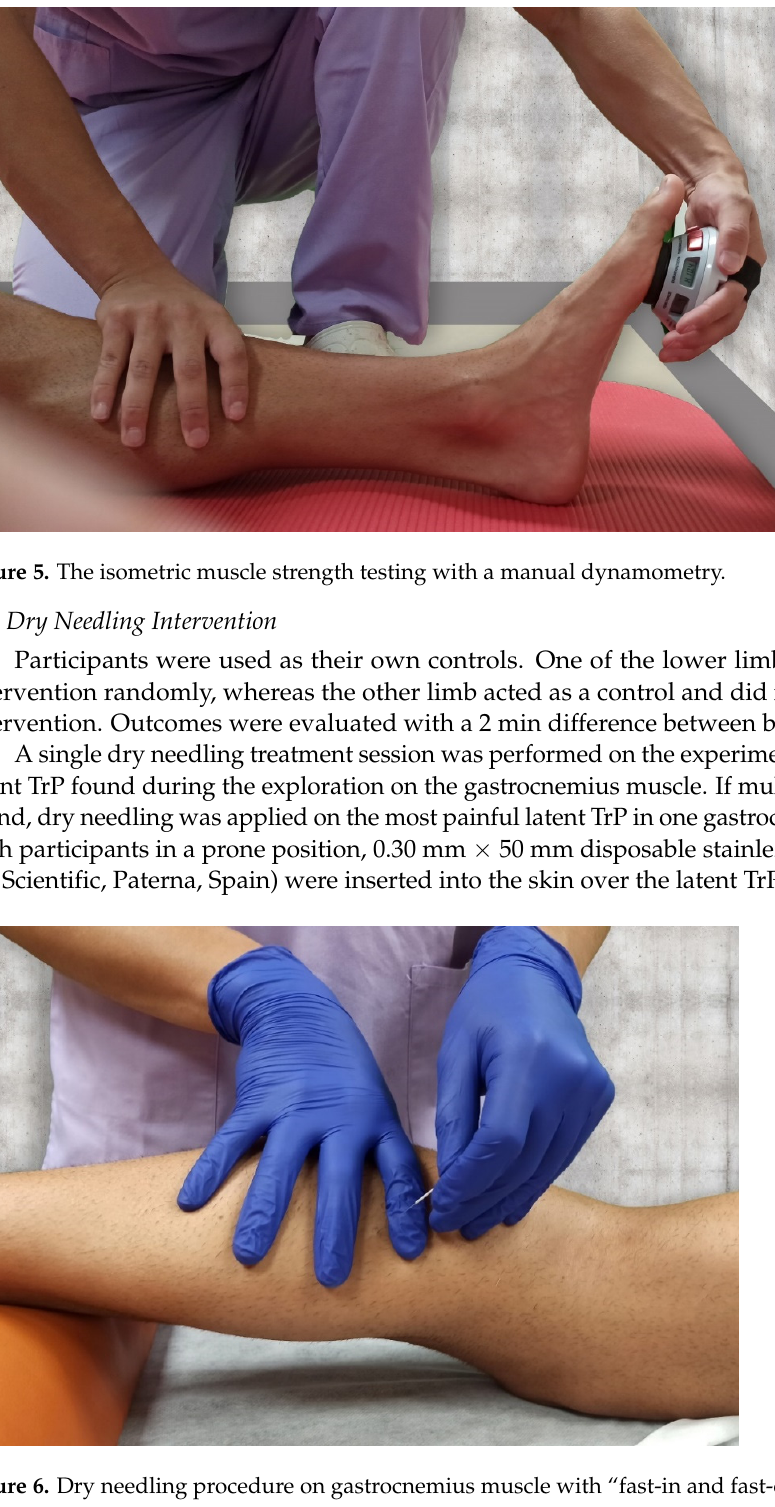
Figure 4. The lunge test was used to measure the ankle dorsiflexion range.